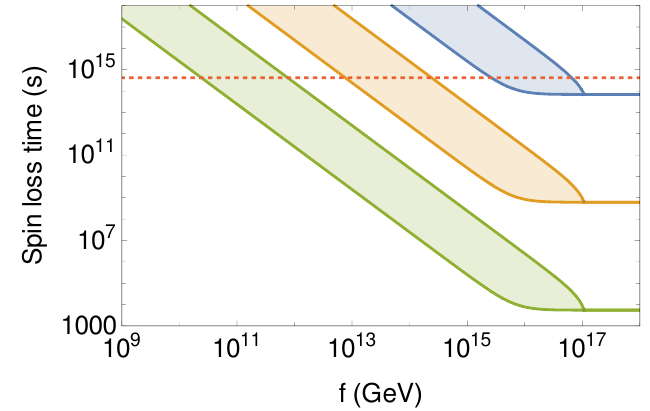
Figure 2 . The relation between the spin loss time by the axion cloud and the axion decay constant. The blue, orange and green bands are for (cid:22) (cid:30) = 10 (cid:0) 20 ; 10 (cid:0) 15 and 10 (cid:0) 10 eV, respectively. The upper (lower) lines of the band correspond to C = 10 (cid:0) 6 (10 (cid:0) 3 ). The red dotted line shows the accretion time scale, eq. (2.7) with (cid:15) = 0 : 3. We take ~ a = 1 and (cid:11) = 0 : 5. The mass of the Kerr black hole is given as (cid:11)=(cid:22) (cid:30) G for each bands, i.e., M BH =M (cid:12) (cid:24) 10 10 ; 10 5 and 1 for the blue, red and green band,